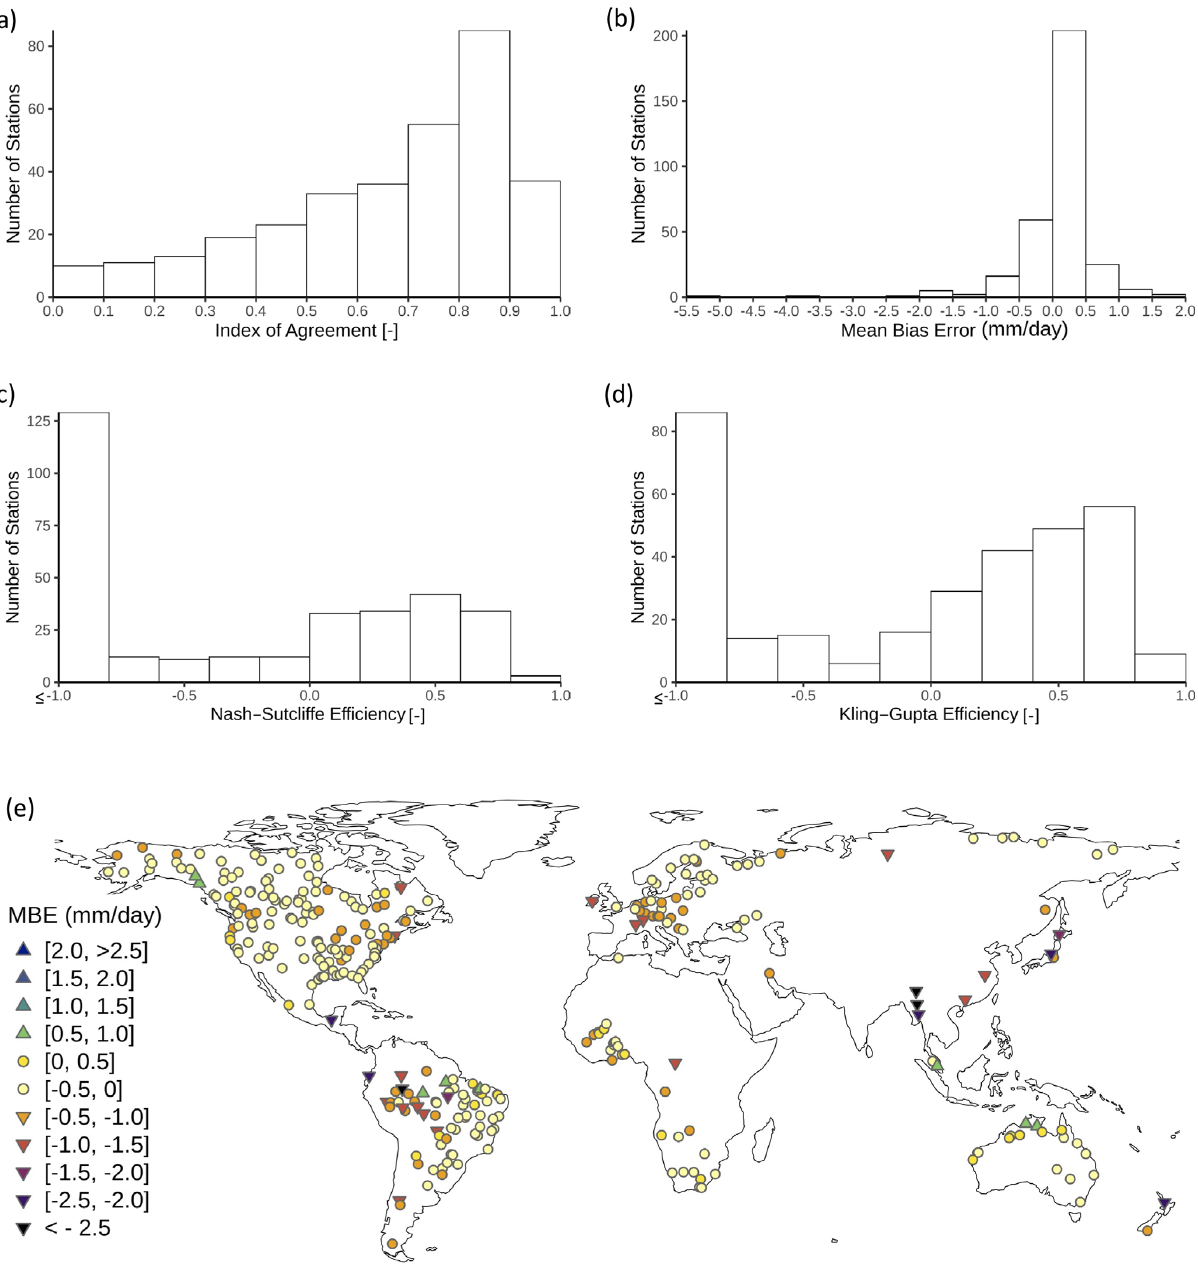
Figure 4. Frequency distribution of the index of Agreement (a) , the mean bias error (b) , the Nash–Sutcliffe efficiency (c) , and the Kling– Gupta efficiency (d) for daily average discharge. Panel (e) shows a map of mean bias error in daily discharge [mmd − 1 ], illustrating the spatial variation in bias. The average index of agreement is 0.56, and average mean bias error is − 0 . 07mmd − 1